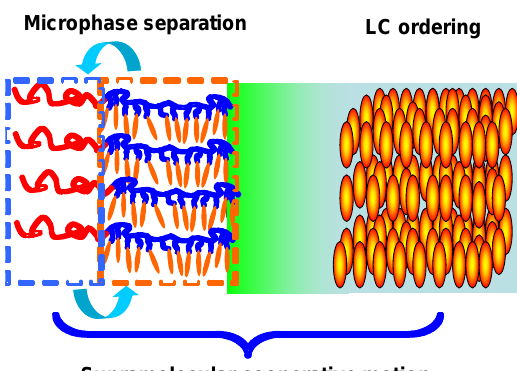
Figure 12. Schematic illustration of supramolecular cooperative motion in LC